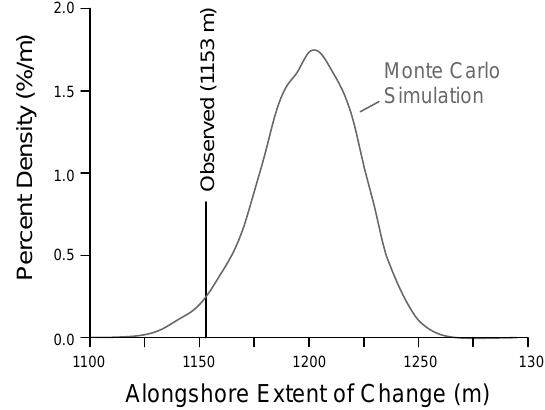
Fig. 13. Probability density function of alongshore extent of change based on a Monte Carlo simulation of random placement (solid curve). Only about 3% of the realizations had alongshore change extents less than or equal to the observed 1153m, suggesting observed failures tended to reoccur at some